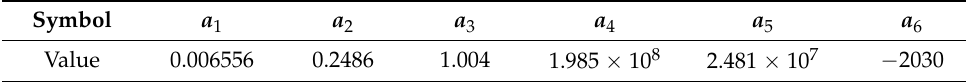
Table 2. Tunable parameters and values of the motor